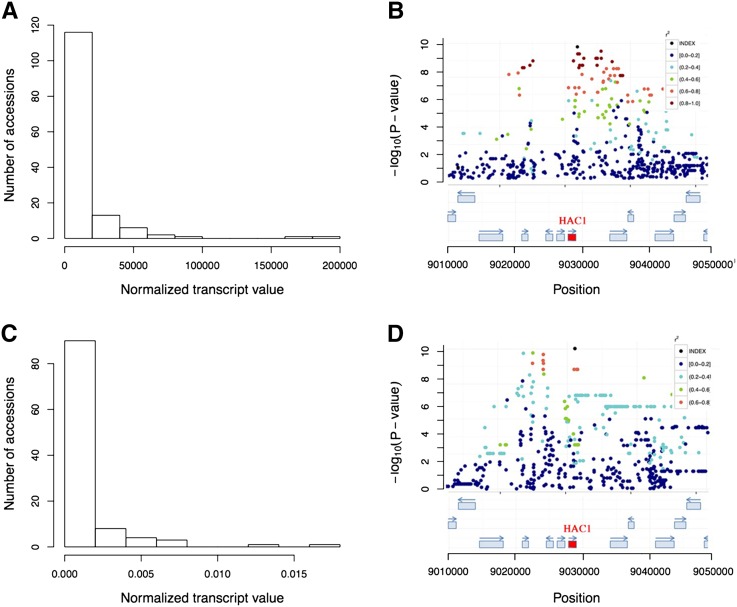
The eQTL analysis detects a highly significant, replicable association for the expression of the gene HAC1 (AT2G21045). The peak SNP is located in an exon of HAC1. (A/C) Distributions of transcript-levels for the 140/107 accessions (FPKM/RPKM-values from RNA-sequencing) in the SCHMITZ-data (A) and DUBIN-data (C) (Schmitz et al. 2013; Dubin et al. 2015), respectively. (B, D) Illustrations of the association-profiles (Kierczak et al. 2015) for expression of the gene AT2G21045 (HAC1) in the SCHMITZ-data (B) and the DUBIN-data (D) (Schmitz et al. 2013)/(Dubin et al. 2015), respectively. There is a highly significant cis-eQTL to a SNP located in an exon of HAC1.